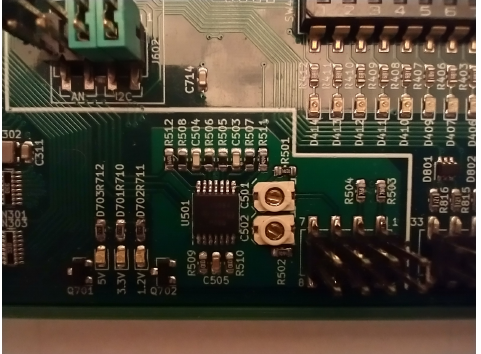
Figure 4. Layout of the DSO voltage input channel. The two white rectangular components in the center are the variable capacitors used to compensate for the voltage divider.